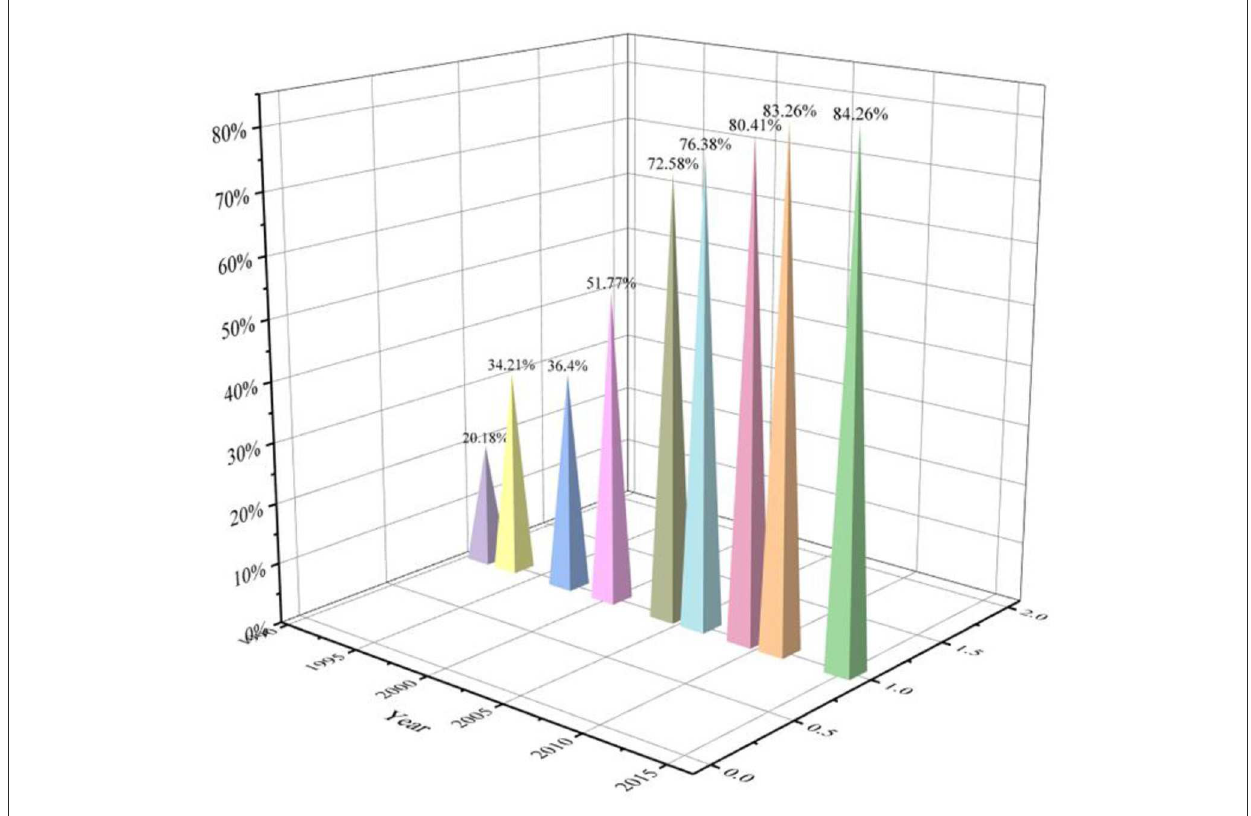
FIGURE10 Medicine taking rate of hypertension in